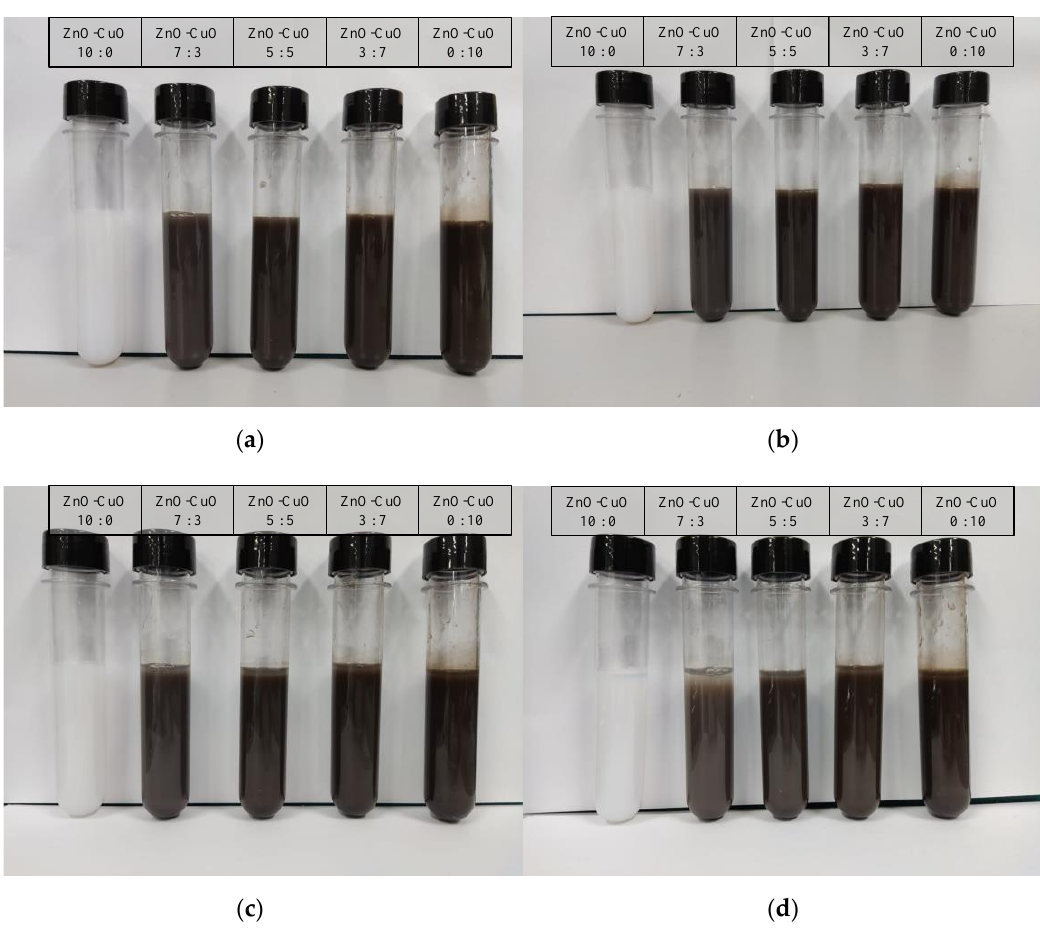
Figure 9. Visual observation on the sedimentation for different mixing ratio of ZnO-CuO/water hybrid nanofluids with surfactant-SDBS at ( a ) 24 h, ( b ) 48 h, ( c ) 72 h, and ( d ) 96 h.